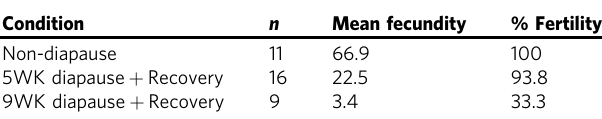
Table 1 Four-day fecundity and fertility in non-diapause and post-diapause female fl